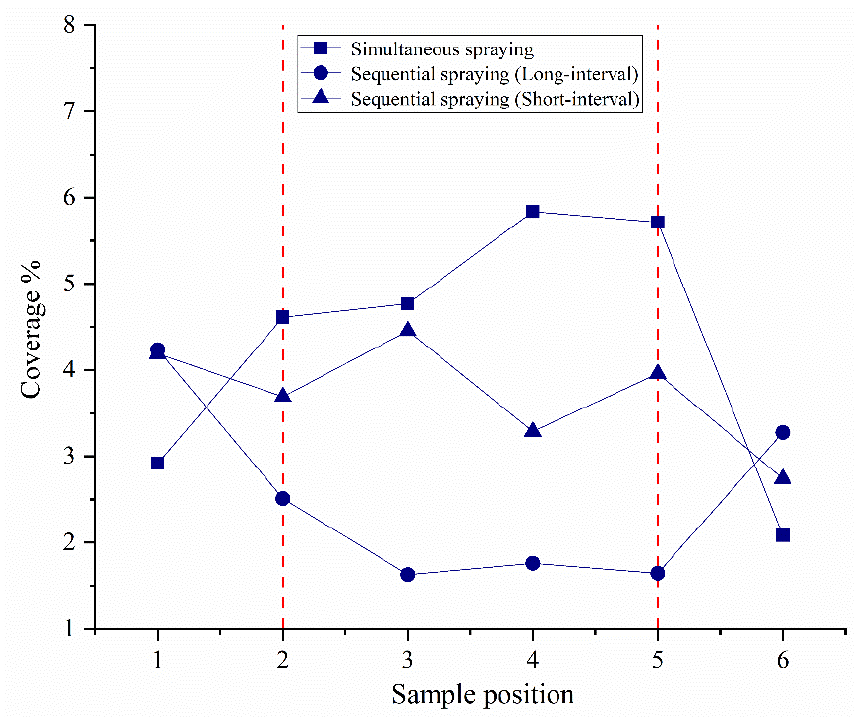
Figure 18. Outdoor test results at a speed of 5 m/s.